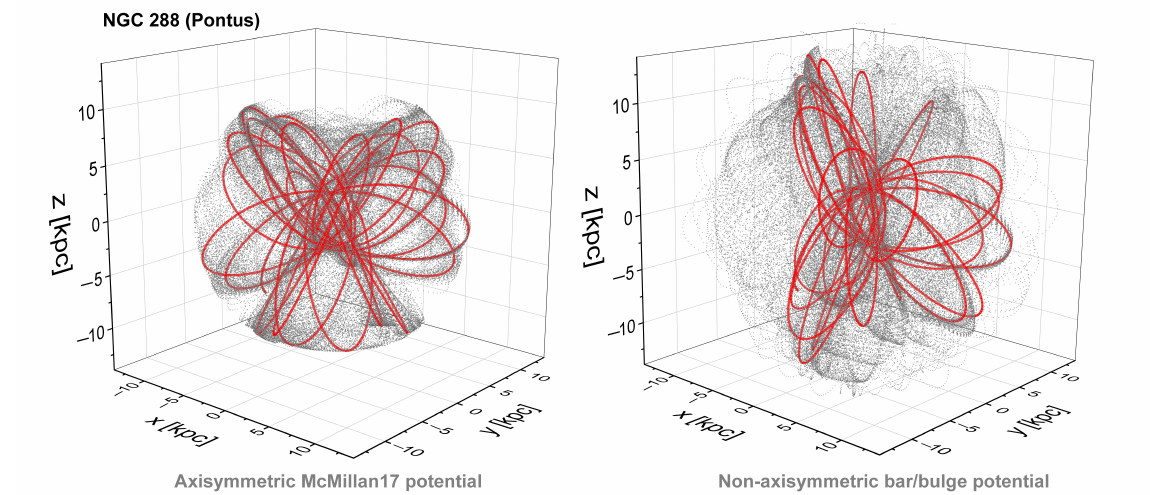
Figure 7. Three-dimensional orbits of globular cluster NGC 288 in the axisymmetric potential McMillan17 ( left panel) and in the non-axisymmetric rotating bar/bulge potential ( right panel). The red lines show the orbits for the mean initial conditions. The grey lines show one hundred orbits consistent with the observational errors in these initial conditions.